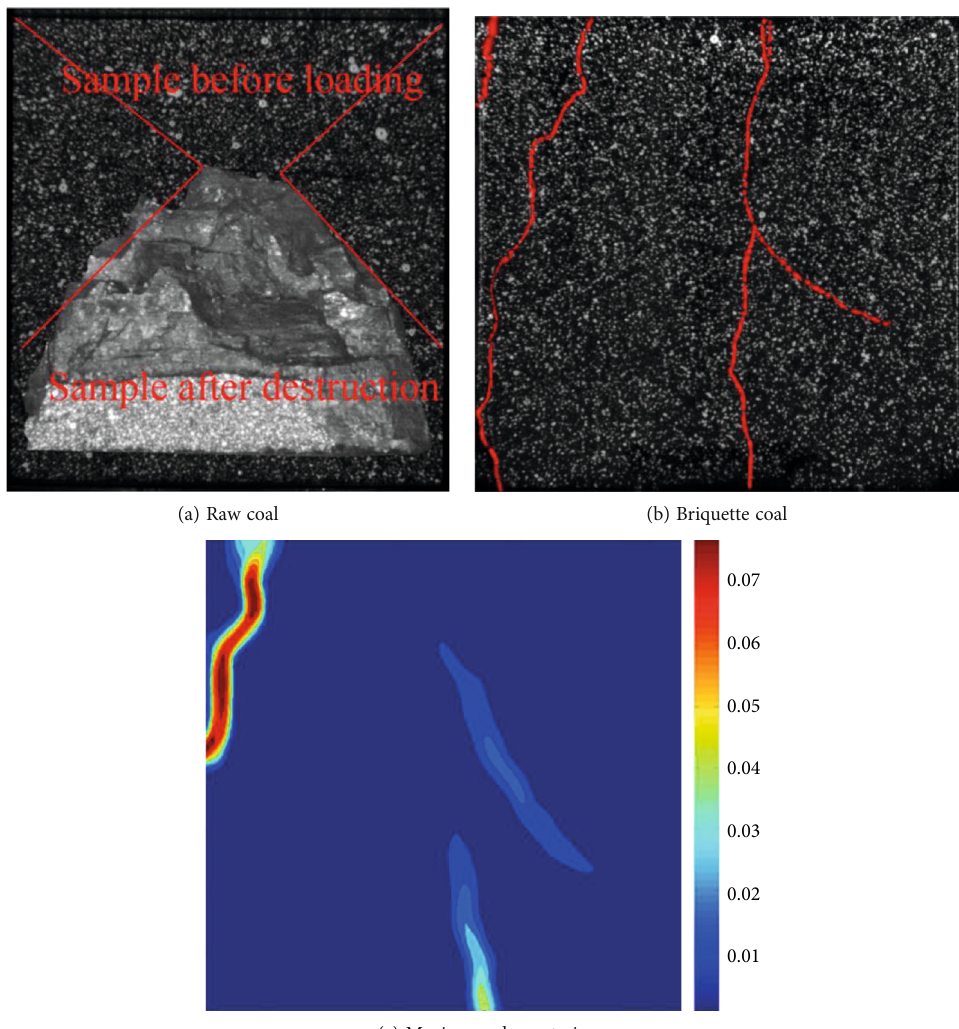
Figure 4: Failure modes of raw coal and briquette coal.